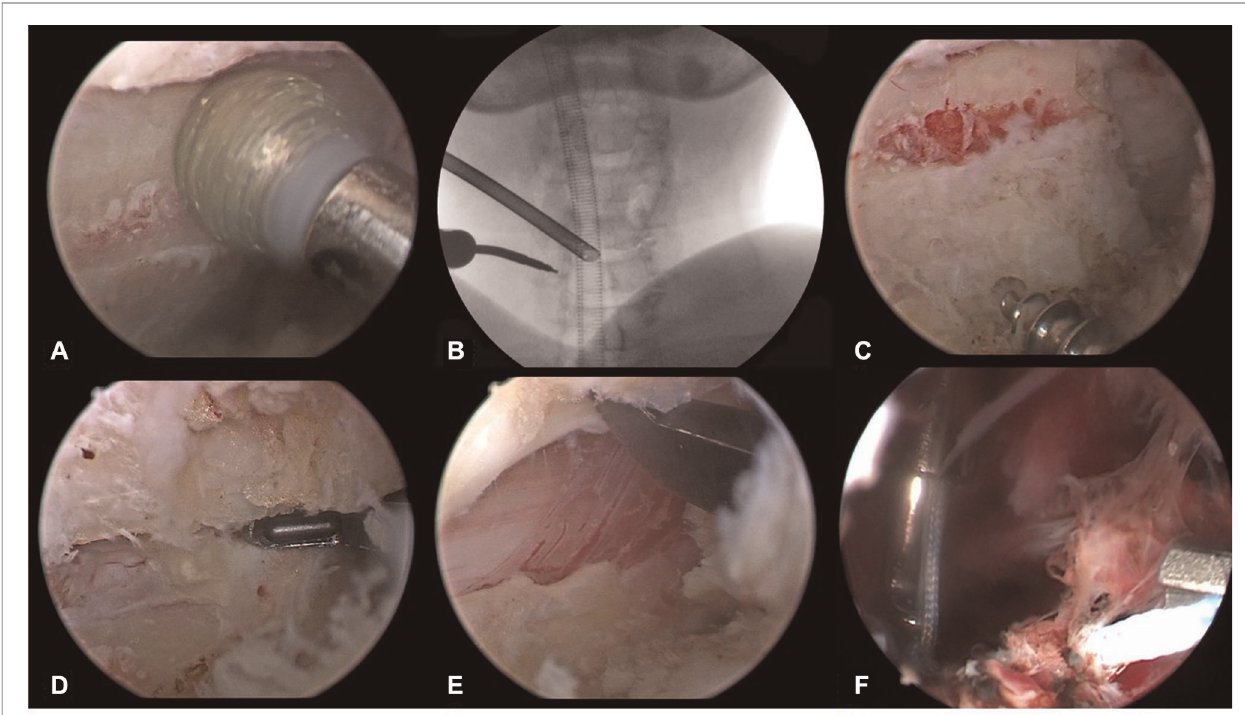
FIGURE 3 | The drilled gutter was fi rst completed using 4-mm diamond burr on the hinge side ( A ) Insertion hole for the suture anchor was also prepared using 2-mm diamond burr on the hinge side and con fi rmed under fl uoroscopy ( B ) Suture anchor was screwed in the lateral mass ( C ) The remained ventral cortical bone on the open-door side was resected using 1-mm Kerrison rongeur ( D ) The lamina door was raised by a 2-mm Kerrison rongeur ( E ) The sutures was knotted tightly to maintain the lamina door in open position ( F